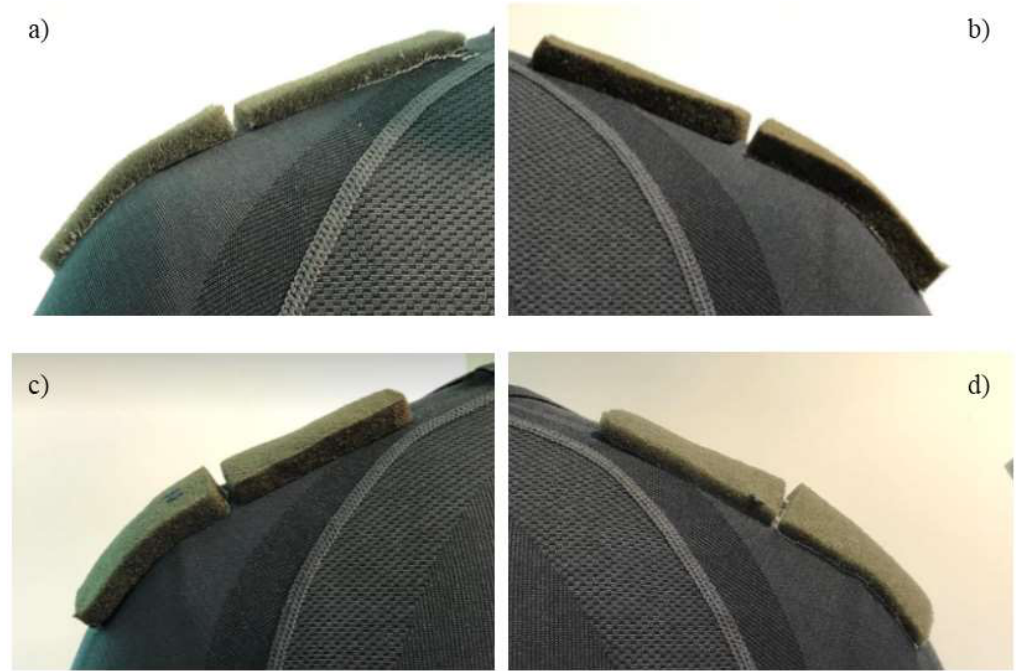
Figure 2. Images of the prototype garment, ( a ) front view conventional foam; ( b ) front view auxetic foam; ( c ) back view auxetic foam; ( d ) back view conventional